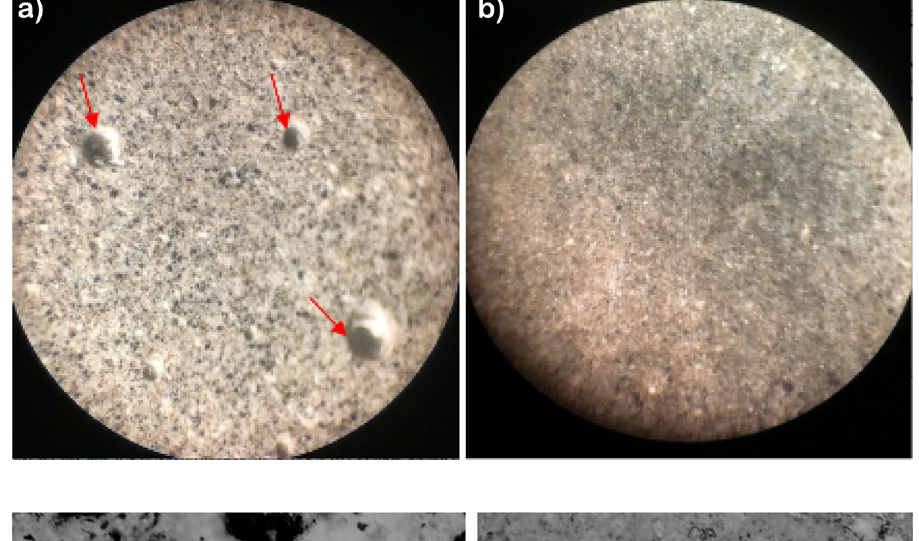
Fig. 10 a – c. 200 × magnifica- tion of low pressure com- pacted Portland cement ( a ), high-pressure compacted Portland cement ( b ), and high- pressure compacted cement with 6.0 wt% of PFP ( c